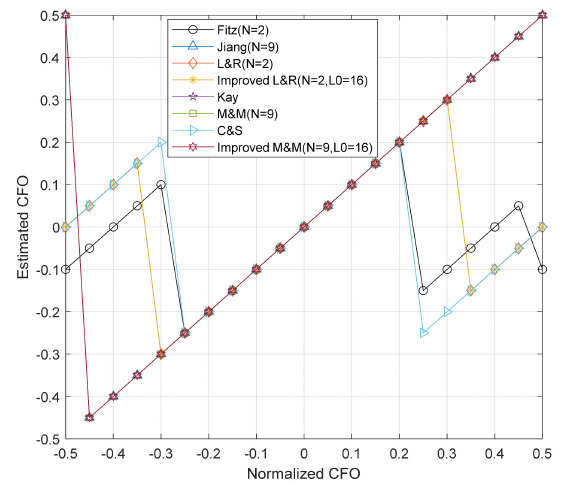
Figure 4. Estimation range of different CFO estimation